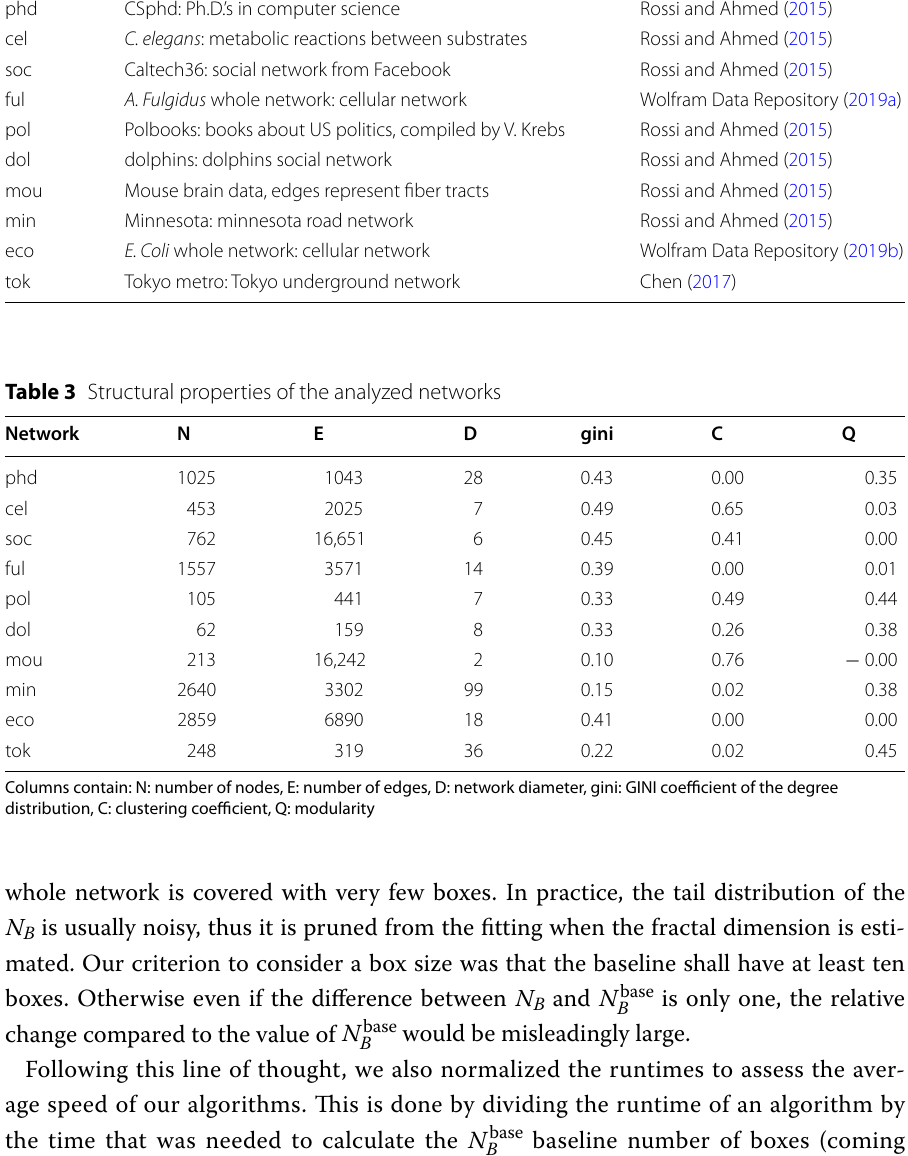
Table 2 The analyzed networks